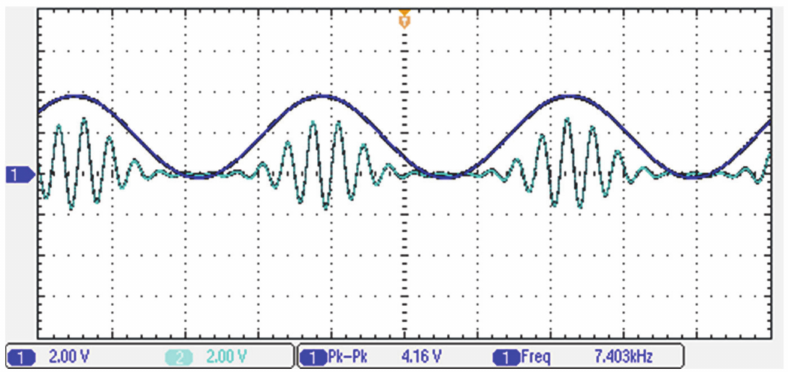
Figure 30. The measurement result of the AM signal generator using sine wave input